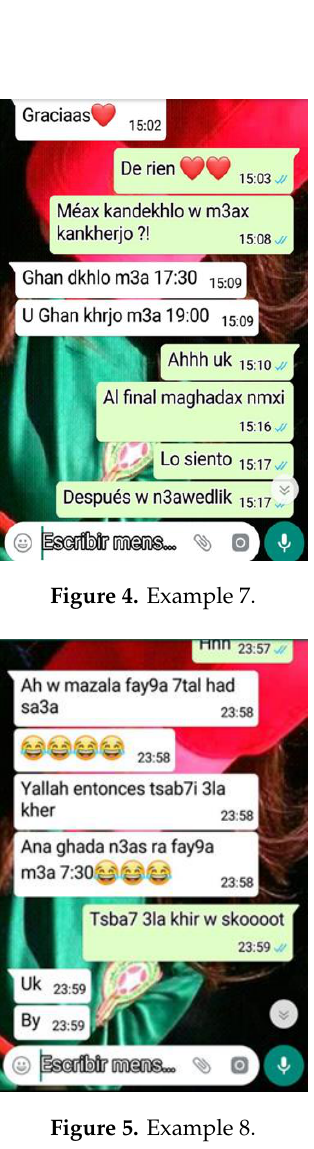
Figure 4 (translation): WhatsApp chat